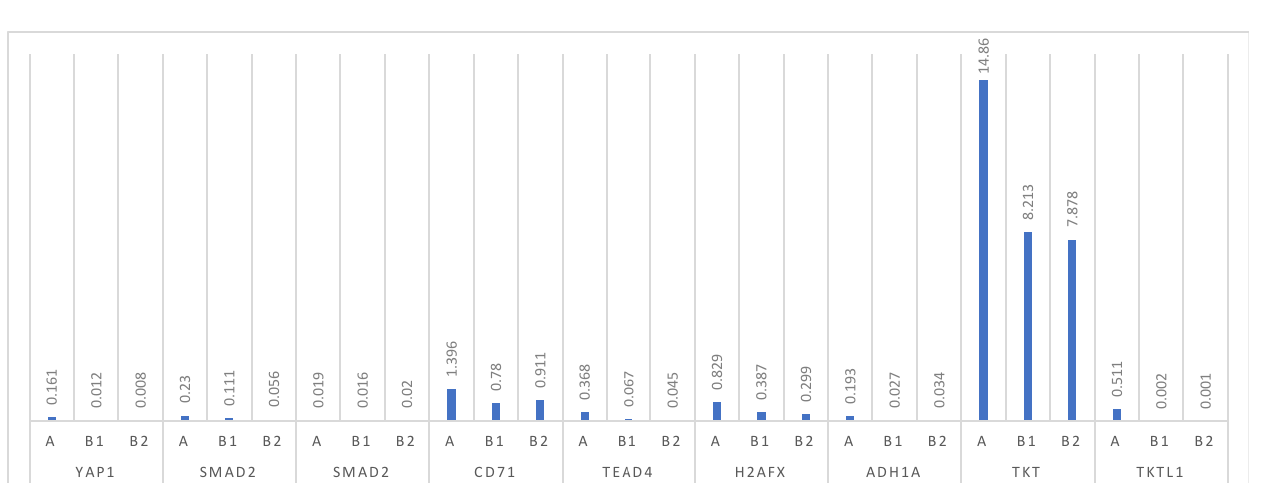
Table 5. Comparison of the tested proteins immunohistochemical expression.